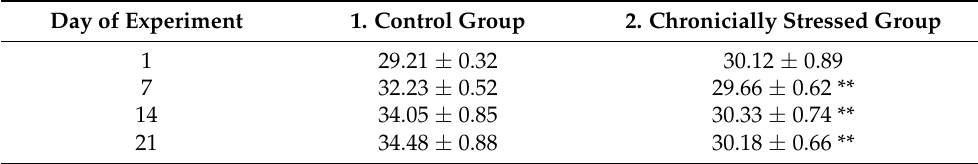
Table 2. The average weight of mice (g) measured every 7 days during the experiment. Day of